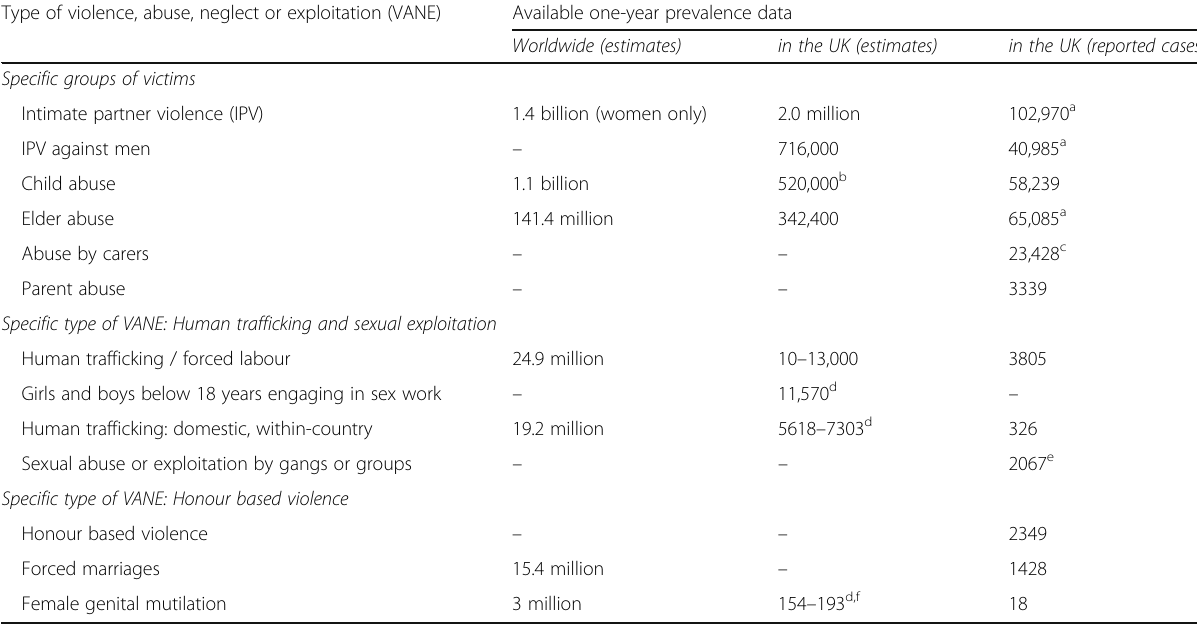
Table 1 One-year prevalence data of different types of violence, abuse, neglect or exploitation (VANE) worldwide and in the UK Type of violence, abuse, neglect or exploitation